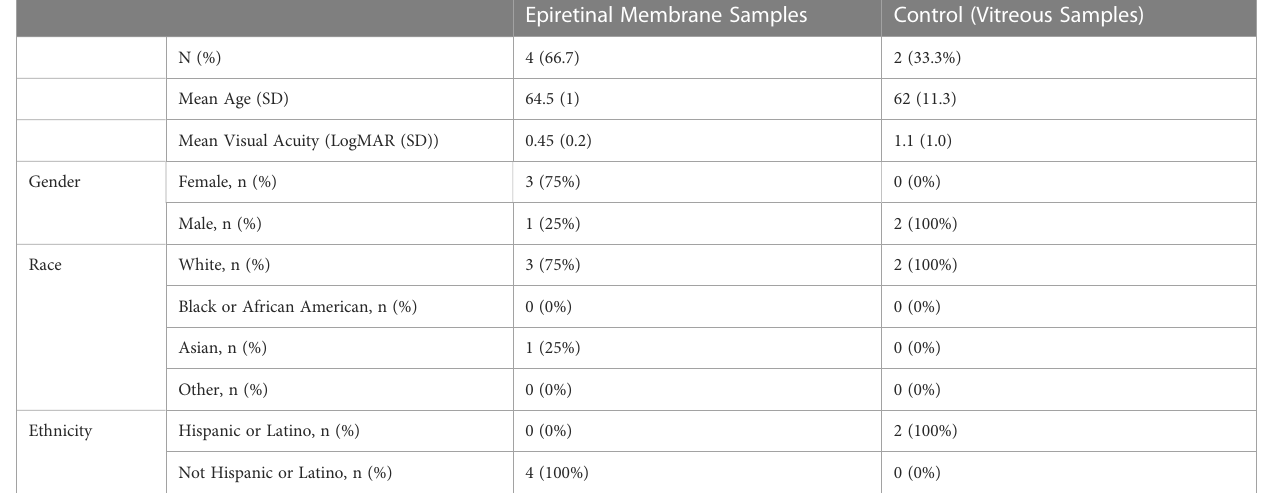
Epiretinal Membrane